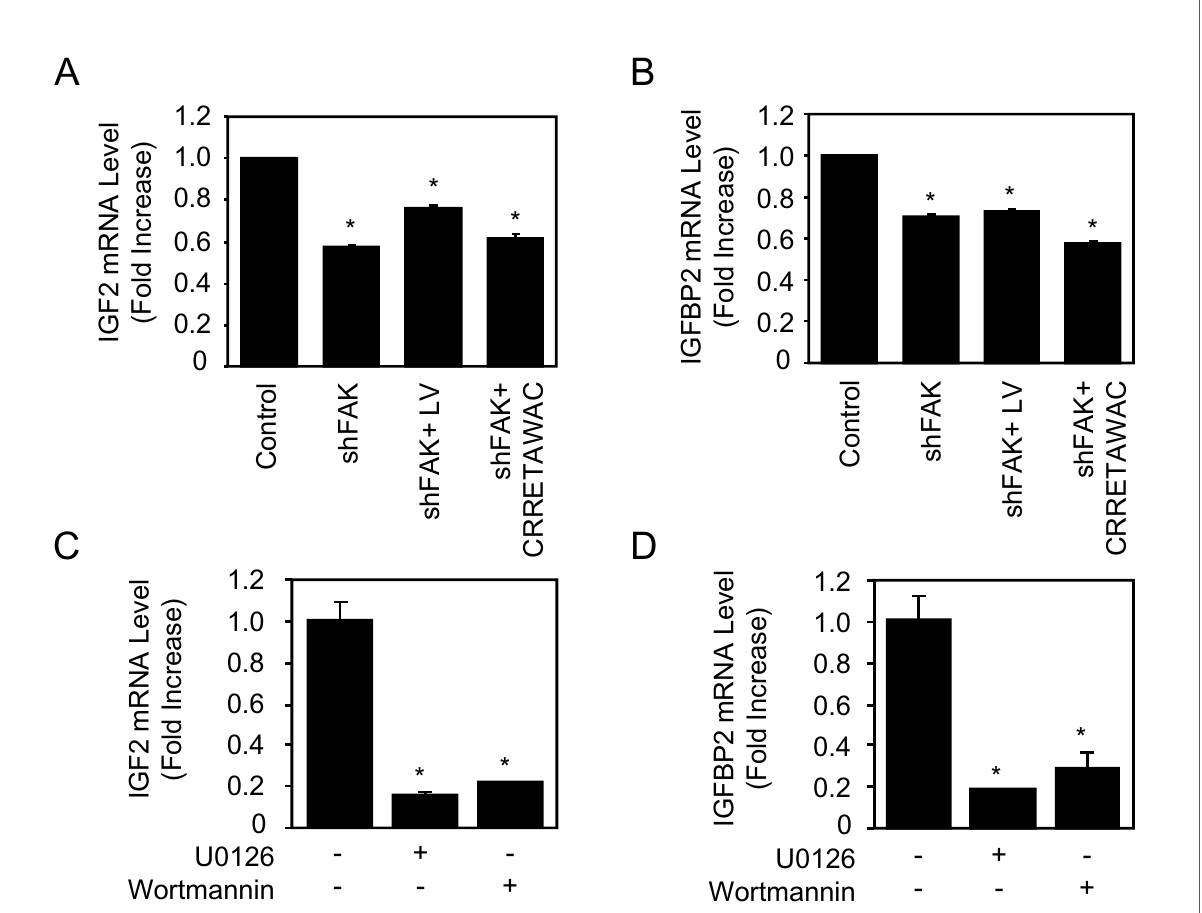
Figure 5 Inhibition of ITGA5-Induced Signalling Abrogates IGF2/IGFBP2 Expression in hMSCs . Adult hMSCs transduced with a lentiviral vector encoding ITGA5 or treated with the agonist peptide (CRRETAWAC; 100 μg/ml), and control cells were transiently transfected with a specific shRNA targeting FAK. Total RNA was collected and used for quantitative RT-PCR analysis of IGF2 ( A ) and IGFBP2 ( B ). Adult hMSCs were treated with the MEK inhibitor U0126 (10 μM), or the PI3K inhibitor wortmannin (50 nM) for 24 hours and IGF2 and IGFBP2 mRNA levels were determined by quantitative RT-PCR analysis ( C-D ). Results are expressed as mean ± SD of treated over control ratio after normalization to 18 S expression. *: significant difference with untreated cells ( P